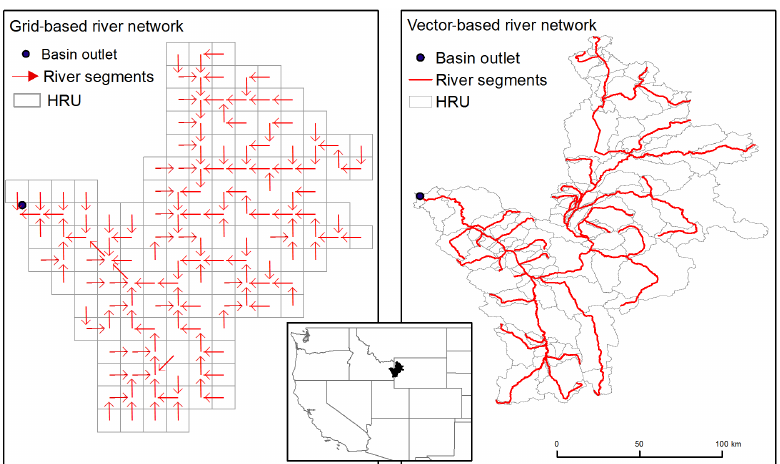
Figure 1. Comparison of 1 / 8 ◦ ( ∼ 12km) gridded river network and vector river network from United States Geological Survey (USGS) Geospatial Fabric for the upper part of Snake River basin (Viger,